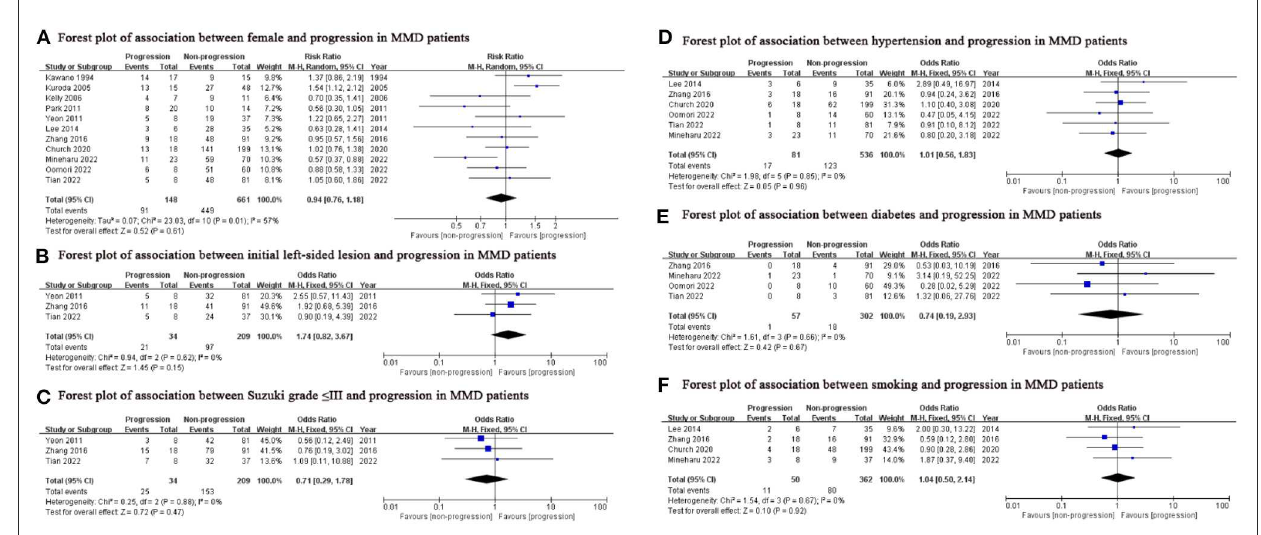
FIGURE3 Potential predictors which were not significantly associated with the progression in this meta-analysis. MMD, moyamoya disease; M-H, Mantel-Haenszel; df, degrees of freedom; CI, Confidence Interval.